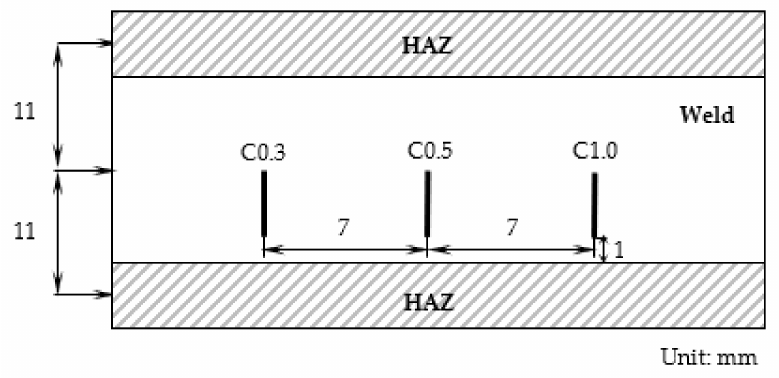
Figure 2. Specimen with artificial narrow cracks.